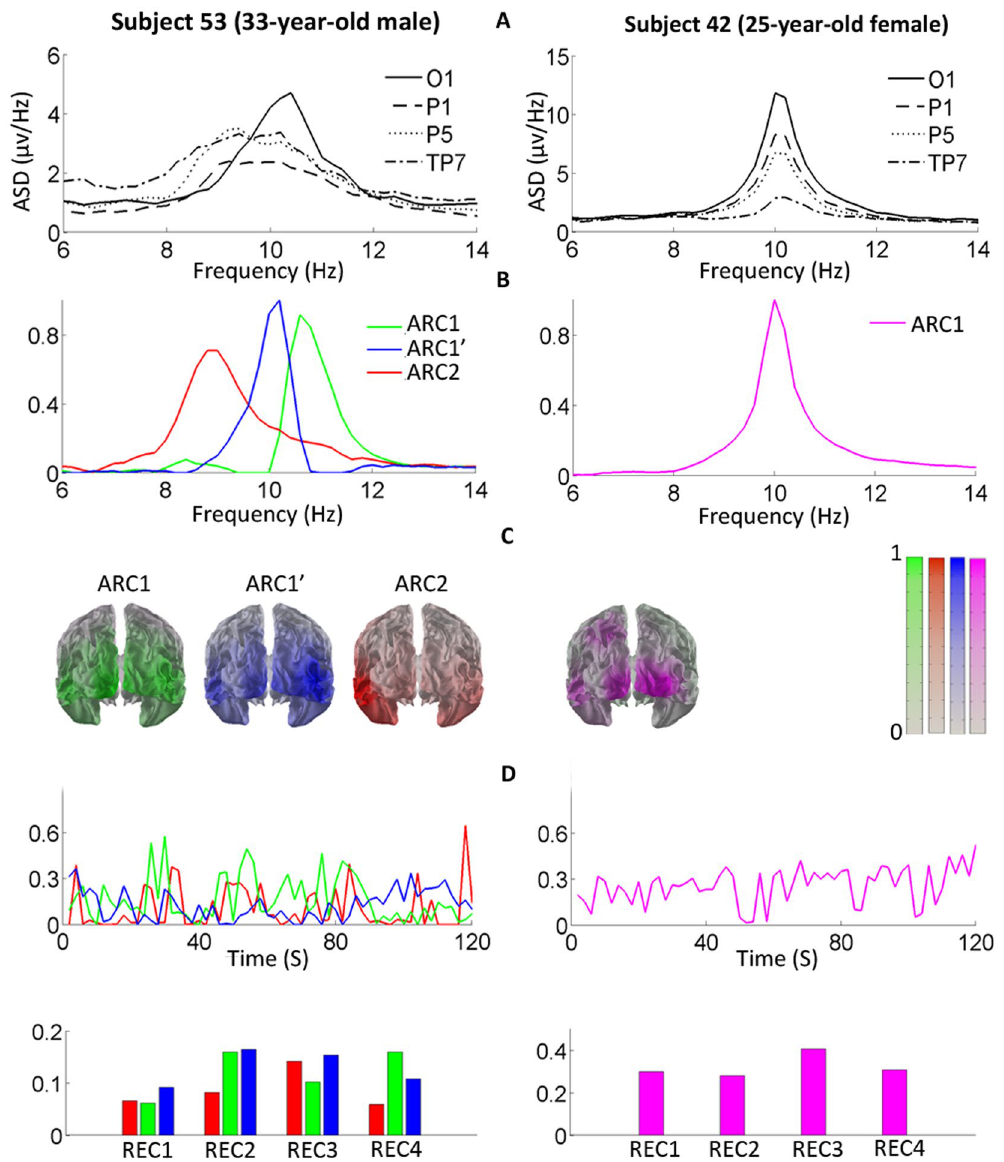
Figure 3. Individual examples of three- and one-component structures of alpha rhythm. All designations are as in Fig. 2. See Results for